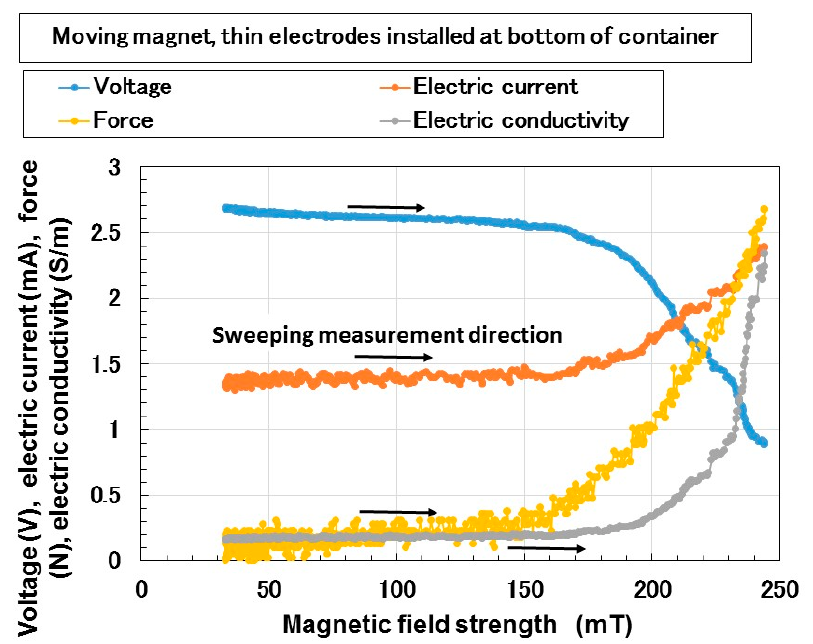
Figure 9. Voltage, electric current, and electric conductivity of MCF rubber liquid, and force acting on the electrodes for a moving magnet and with electrodes installed at the bottom of the container.